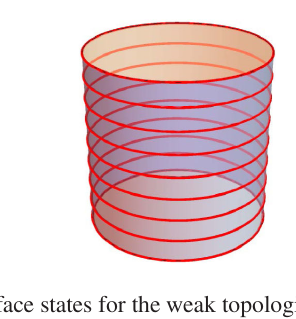
FIG. 2. Surface states for the weak topological insulator can be understood as choosing a “ − ” representation for the translation along the “ weak ”